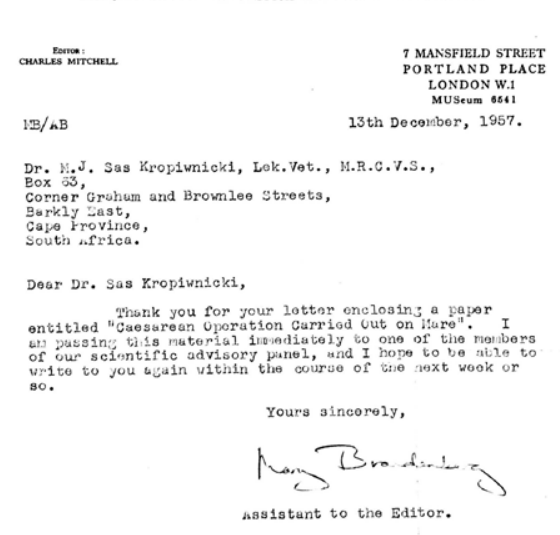
Figure 2: Journal reply